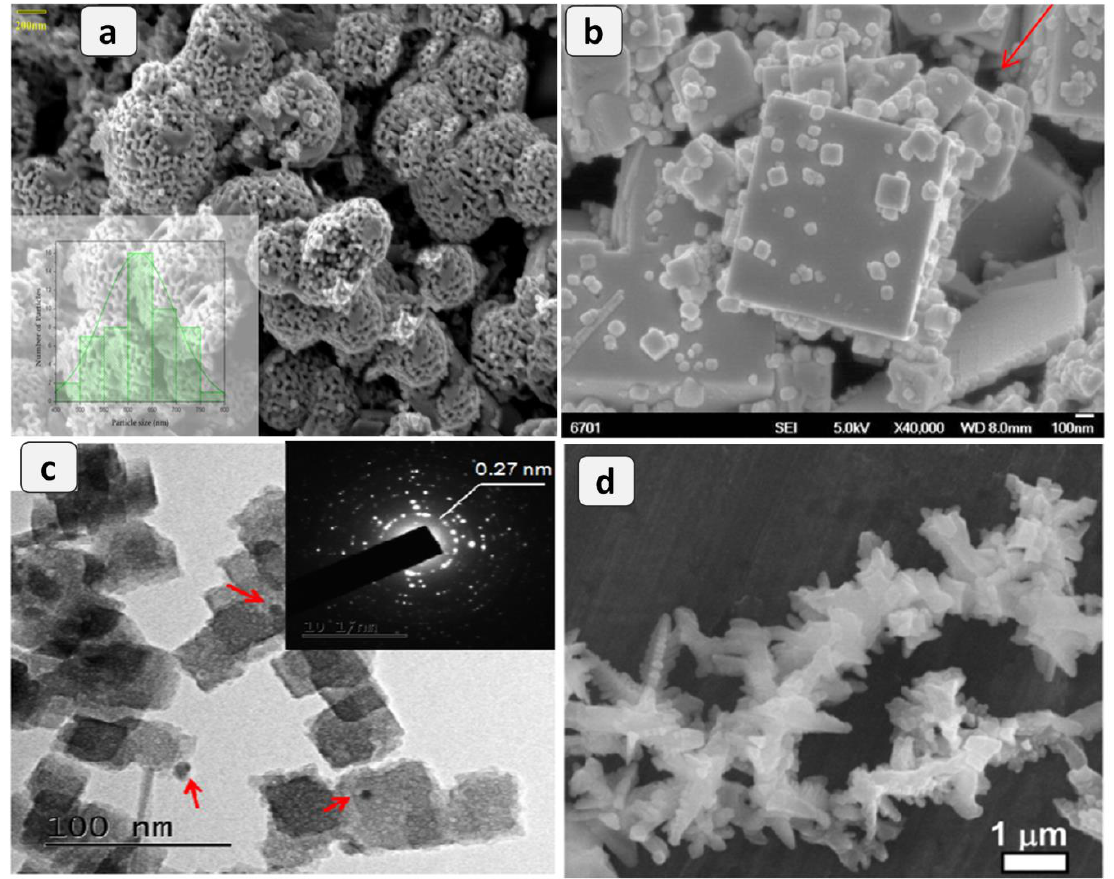
Figure 4. ( a ) FE-SEM image of spherical shaped SrTiO 3 with sponge-like mesoporous morphology.